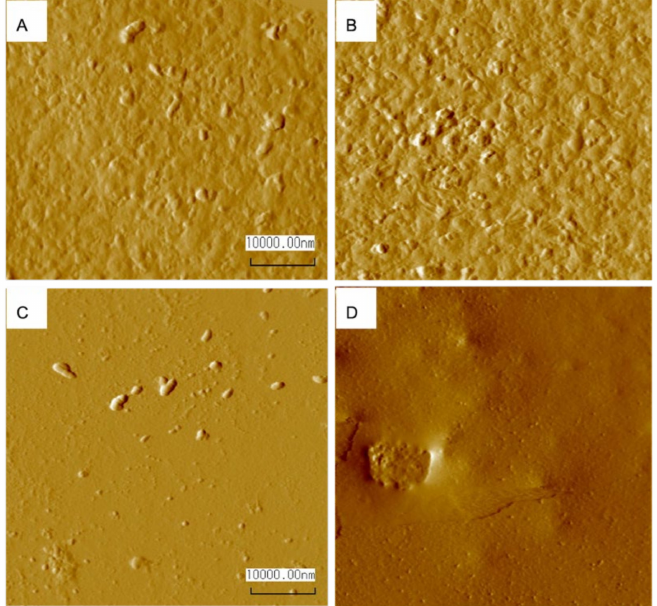
Figure 7. AFM images of ODA-PHA ( A , B ) and α -CD/ODA-PHA ( C , D ) films prepared at 60 ◦